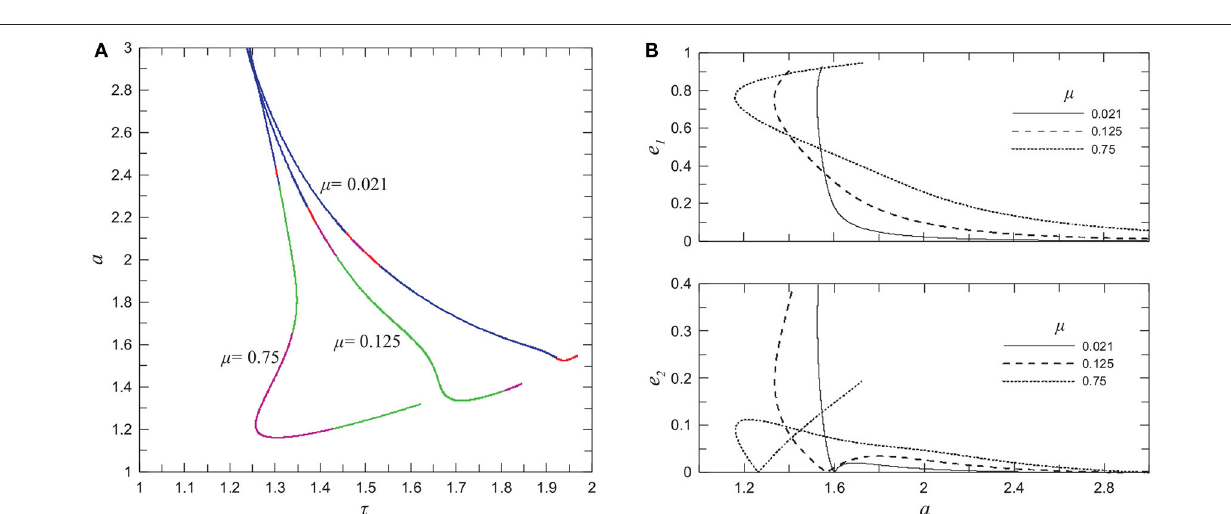
FIGURE 4 | (A) Characteristic curves of families S ′ ( a ; µ ) for particular mass values presented in the plane τ − a . Segments of blue color indicate stable orbits while red, magenta and green color present single, double, and complex instability, respectively (B) The initial eccentricities of the inner binary and the outer planet, e 1 and e 2 respectively, along the families presented in the left